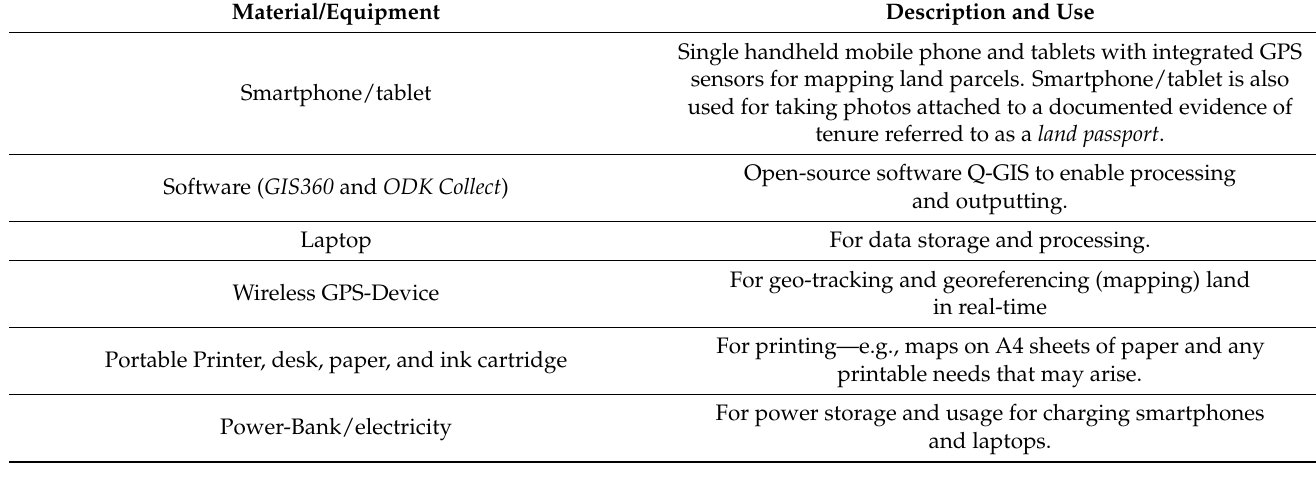
Table 1. Equipment and materials for the youth-led land survey/inventory Juaben-Atia (Source: Authors’—based on materials for land use inventory exercise).